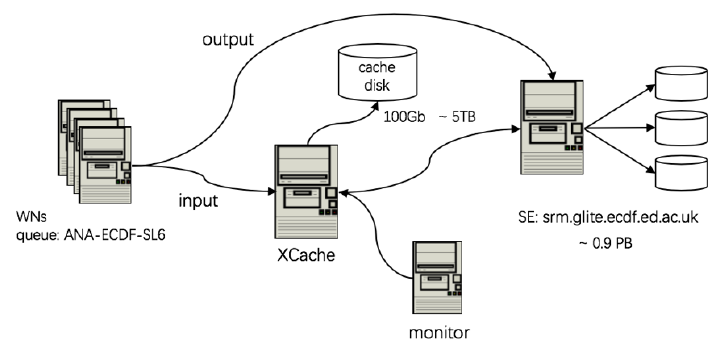
Figure 1. Overview of the XCache